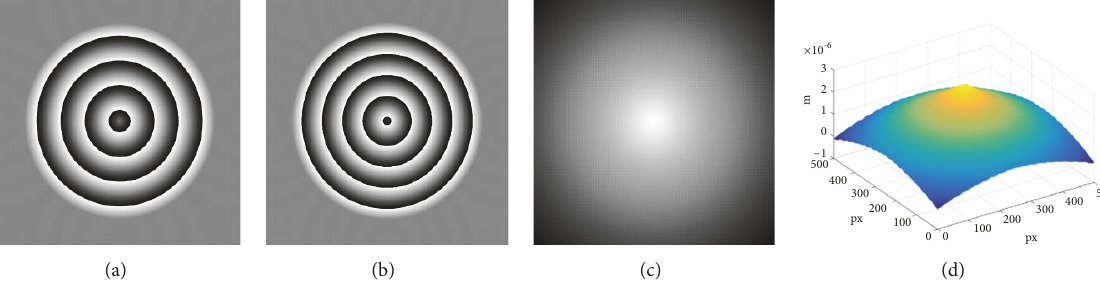
Figure 3: Simulation results for slope: (a) phase distribution for 632.8 𝑛𝑚 , (b) phase distribution for 532 𝑛𝑚 , (c) phase distribution for equivalent wavelength, and (d) 3D view of dual-wavelength phase distribution.